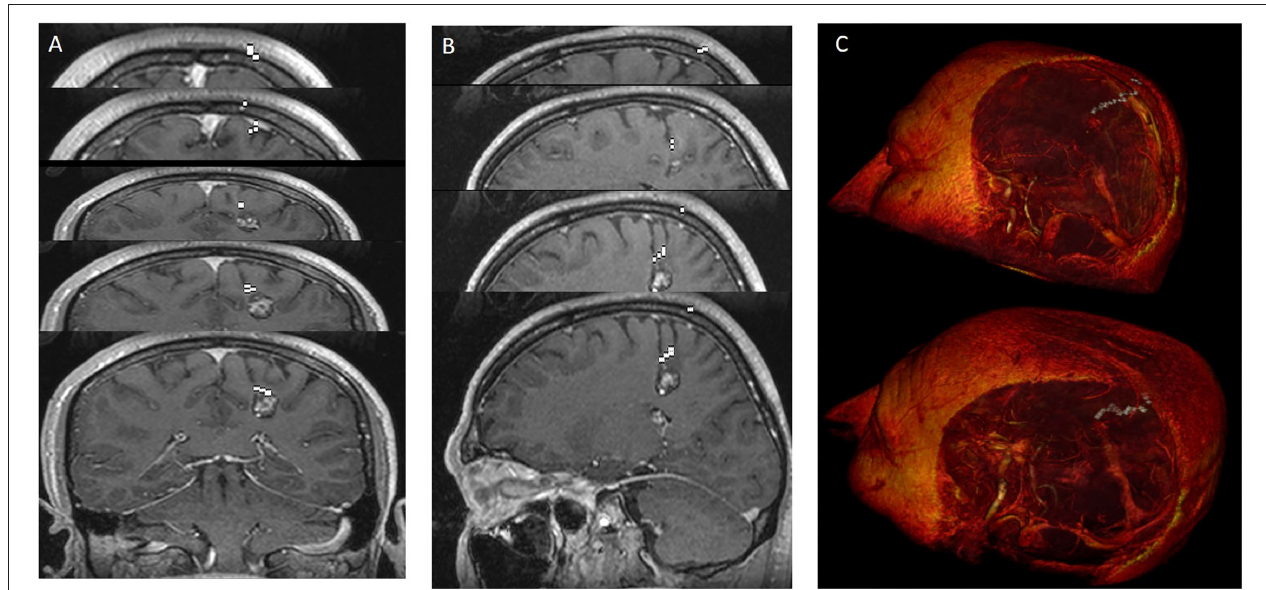
FIGURE 5 | The most ideal cortico-tumoral approach is recommended by RL. Images were added one after another to show the nonlinear pathway. RL extracted the most optimal pathway by performing a random-onset point analysis of the entire intracranial area. Demonstration of the approach reaching the tumor from the base of